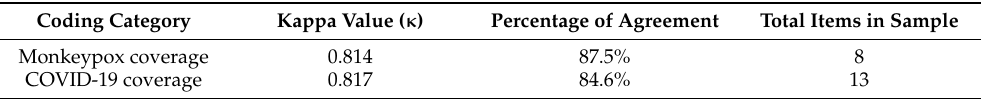
Table 1. Kappa statistics and coding agreement for the samples for the monkeypox and COVID-19